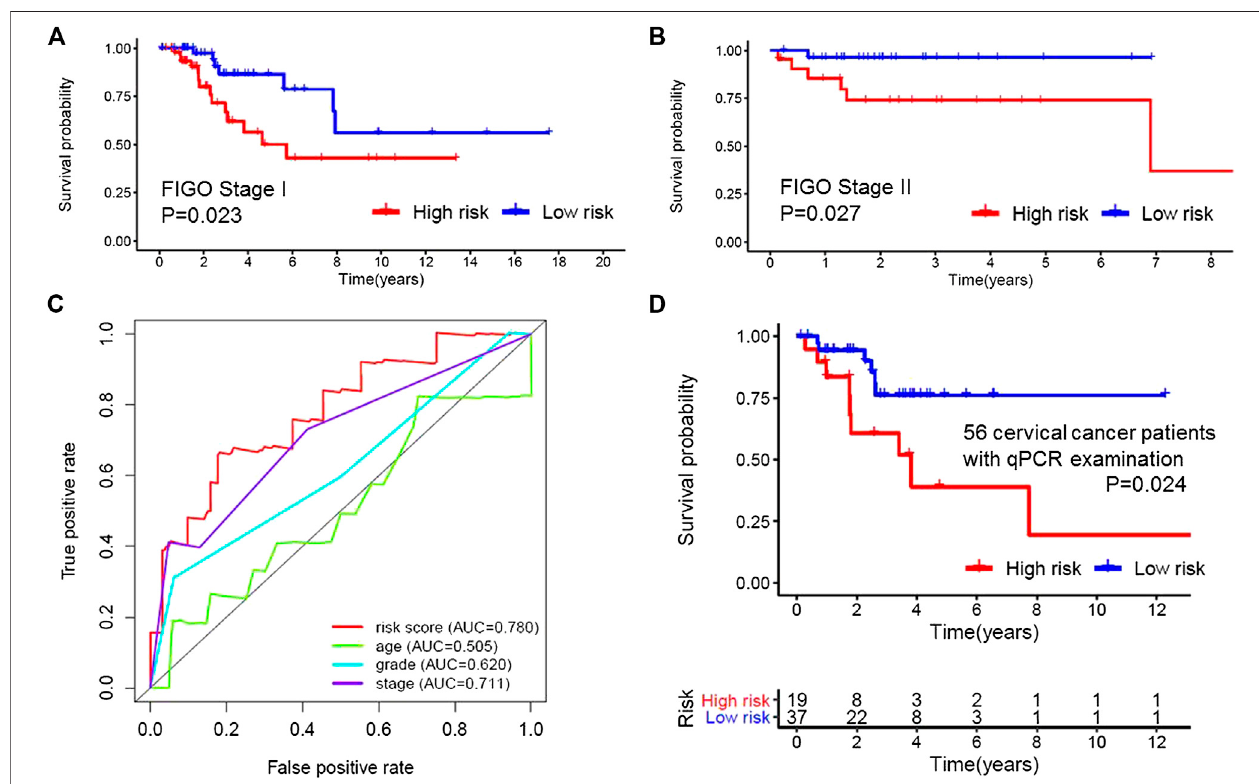
FIGURE 3 | Applicability and reliability of the prognostic model. (A,B) Kaplan – Meier curve of FIGO stages I and II of the high- and low-risk groups. (C) , Receiver operatingcharacteristic (ROC) curveof the risk score, age, grade, and stage. The area under the ROC curve (AUC) of the prediction model was 0.780, which was much better than that of age (0.505), grade (0.620) and FIGO stage (0.711). (D) Kaplan – Meier curve of 56 cervical cancer patients. 56 patients from our cancer center were selectedandQRT-PCRwasusedtocalculatetheexpressionlevelof fi veLongnon-codingRNAs, fi nallytheprognosticmodelwasvalidatedusingtheiraccordingly clinical